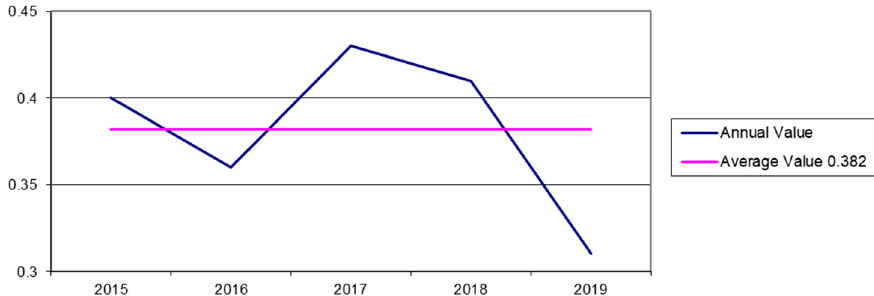
Figure 3. Evolution of the transformation index for electric energy in Spain (kgCO 2 eq / kWh) 2015–2019. Source: Own elaboration, based in official CNMC data (Spain) (www.gdo.cnmc.es).